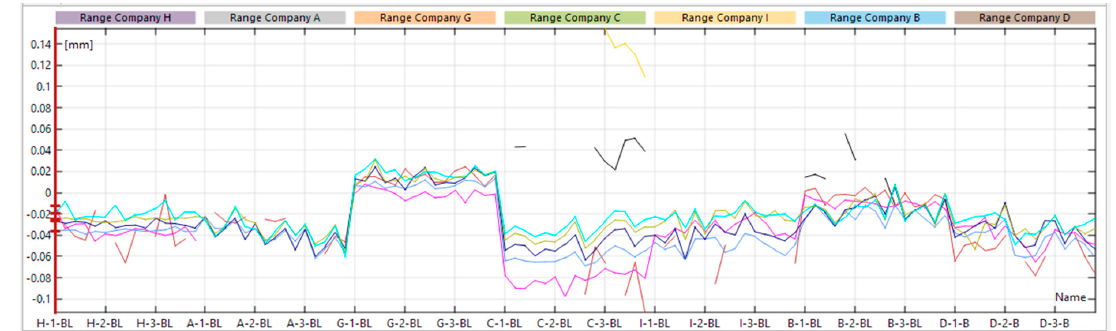
Figure 18. Deviation graph of the pin diameters compared to nominal CAD dimension produced with